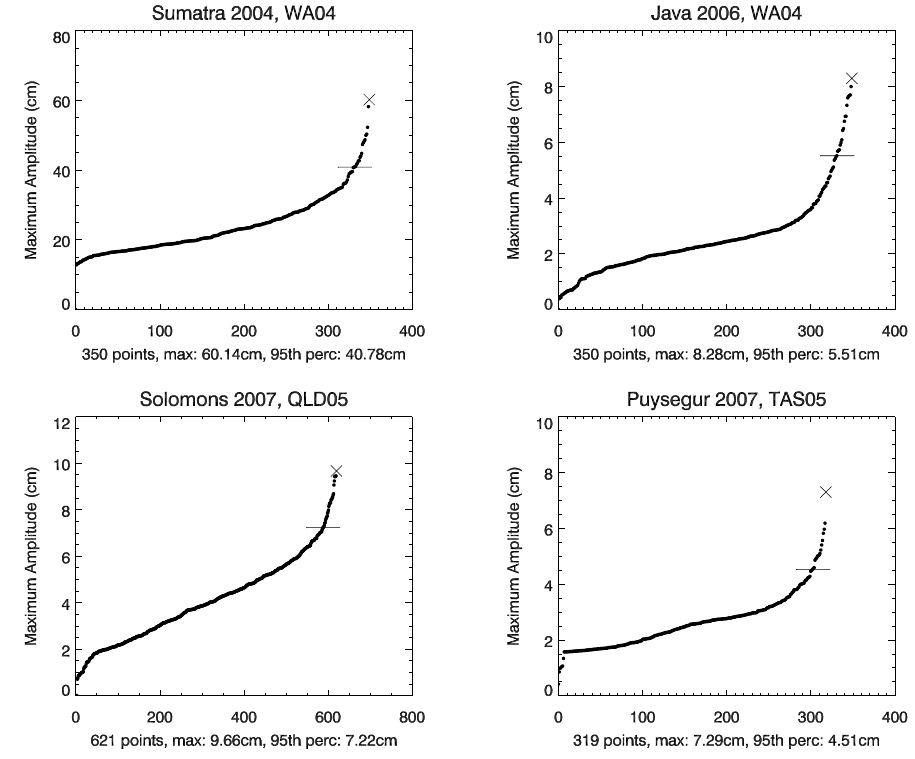
Fig. 2. Ranked values of H max for several coastal zones surrounding the Australian mainland. The maximum value in each zone is marked with a cross and the 95th percentile value is marked with a horizontal bar.